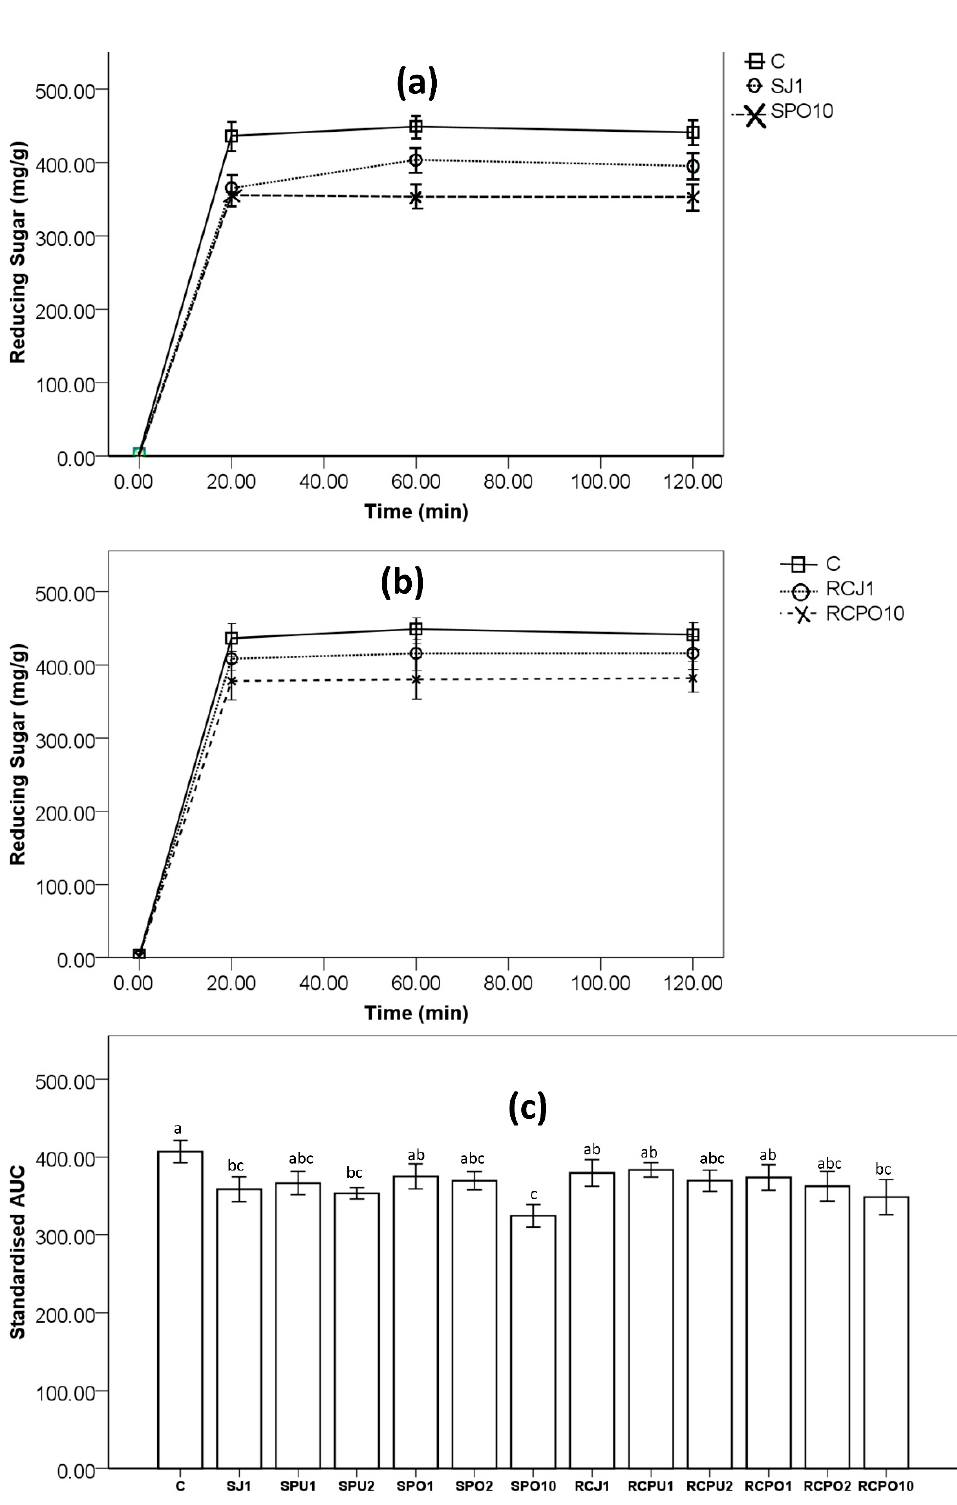
Figure 1. ( a ) reducing sugar release vs. time of C (control), spinach juice 1% pasta (SJ1), spinach pomace 10% pasta (SPO10); ( b ) reducing sugar release vs. time of of C (control), red cabbage juice 1% pasta (RCJ1), red cabbage pomace 10% pasta (RCPO10); ( c ) Value for are under the curve (AUC) of pasta samples, SJ, SPU, SPO represent spinach juice pasta, spinach puree pasta, spinach pomace pasta, respectively; RCJ, RCPU, RCPO represent red cabbage juice pasta, red cabbage puree pasta, red cabbage pomace pasta, respectively; C: control sample, 1, 2 and 10 is the substitution level (g/100 g or %) based on dry weight. The same letters are not significantly different from each other ( p > 0.05) according to the ANOVA- Duncan